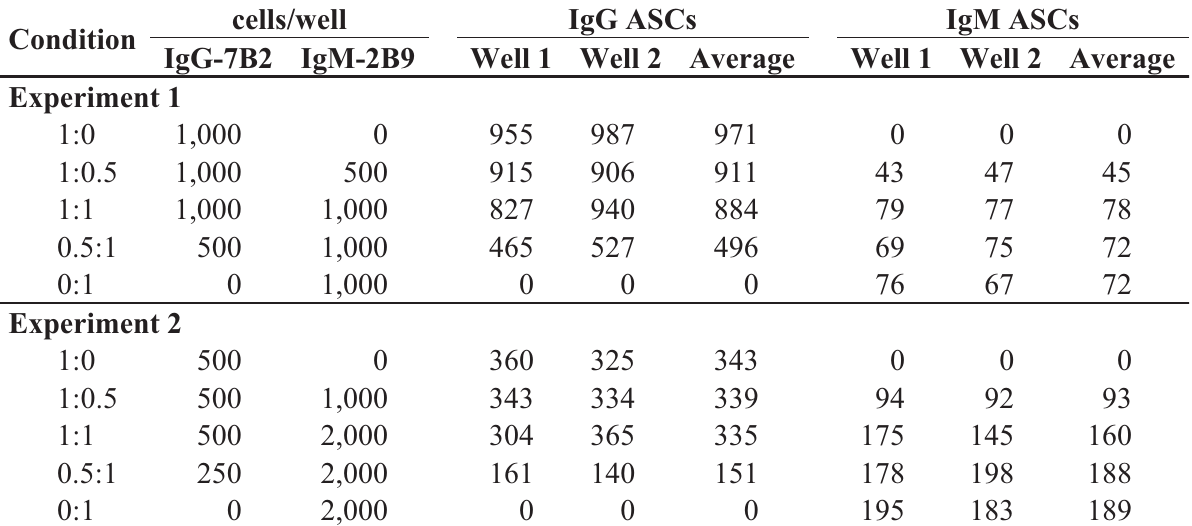
Table 2. IgG and IgM antibody-secreting cells enumerated in two independent experiments using the multiplexed B cell fluorospot assay.